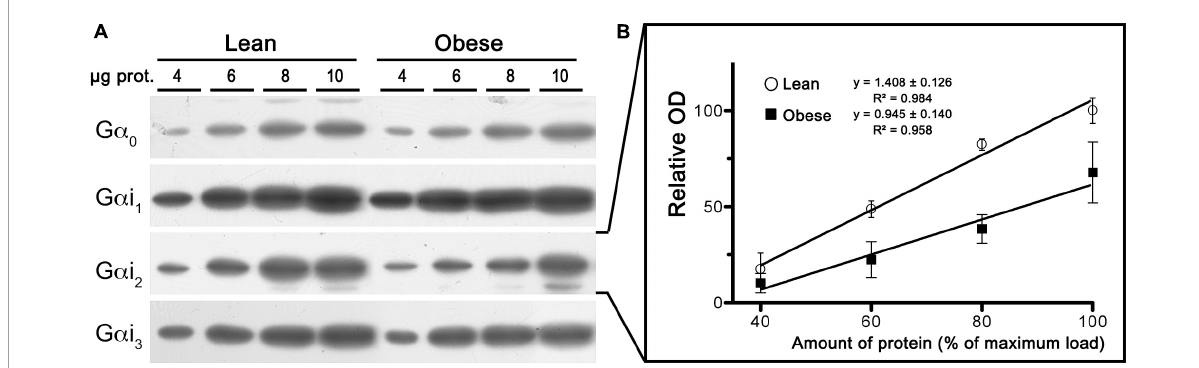
FIGURE10 Expression analysis of G α i / o subunits in crude membranes of mPCx from lean and obese Zucker rats. (A) Representative images of immunoblots using specific antibodies against different G α i / o subunits. Increasing amounts of mPCx membrane samples from lean and obese Zucker rats. (B) Linear regression analysis comparing the relative optical density measurements of G α i 2 -immunoreactivity in crude membrane samples of mPCx from lean ( ◦ ) and obese ( • ) Zucker rats. The correlation coefficients are provided. Data presented are means ± SEM of three independent